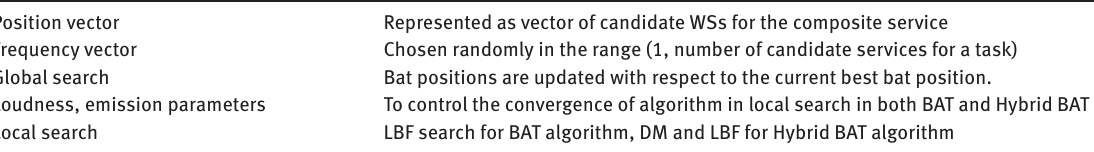
Table 2: Analogy of BAT and Hybrid BAT Algorithms with WS Selection Problem. Position vector